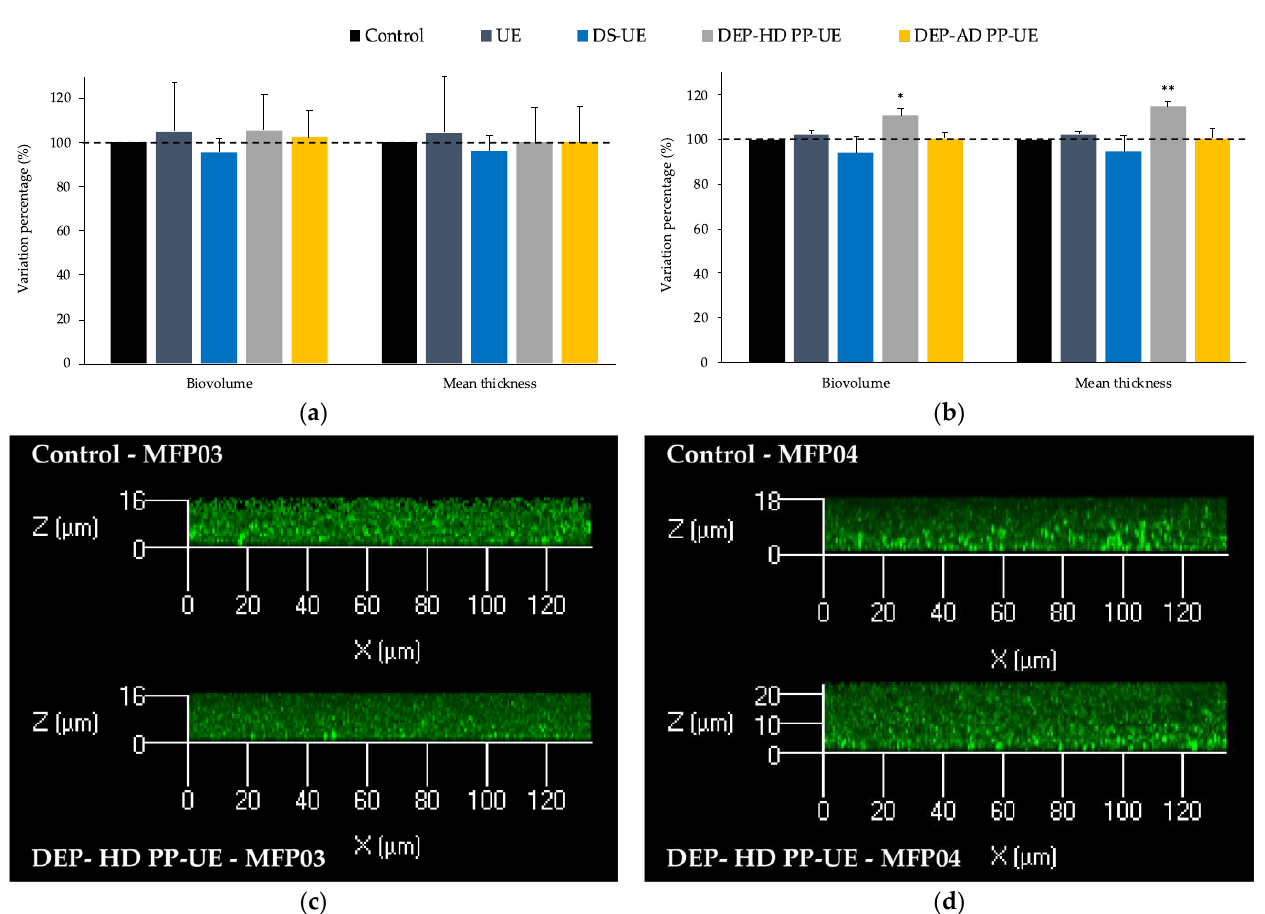
Figure 5. Effects of poly- and oligosaccharide Ulva sp. fractions at 1000 μg/ mL on the biofilm production of ( a ) S. aureus MFP03 ( n = 4) and ( b ) S. epidermidis MFP04 ( n = 4) evaluated by confocal laser scanning microscopy. Significant differences between control (bacteria preliminarily cultured in TSB alone) and treated bacteria preliminarily cultured in TSB in the presence of the fractions are indicated by * p < 0.05 and ** p < 0.01. ( c ) Representative views of X/Z sections of the biofilms formed in control conditions (MFP03 preliminarily cultured in TSB alone) and when MFP03 were preliminarily cultured in TSB in the presence of DEP-HD PP-UE at 1000 μg/ mL. ( d ) Representative views of X/Z sections of the biofilms formed in control conditions (MFP04 preliminarily cultured in TSB alone) and when MFP04 were preliminarily cultured in TSB in the presence of DEP-HD PP-UE at 1000 μg/ mL.